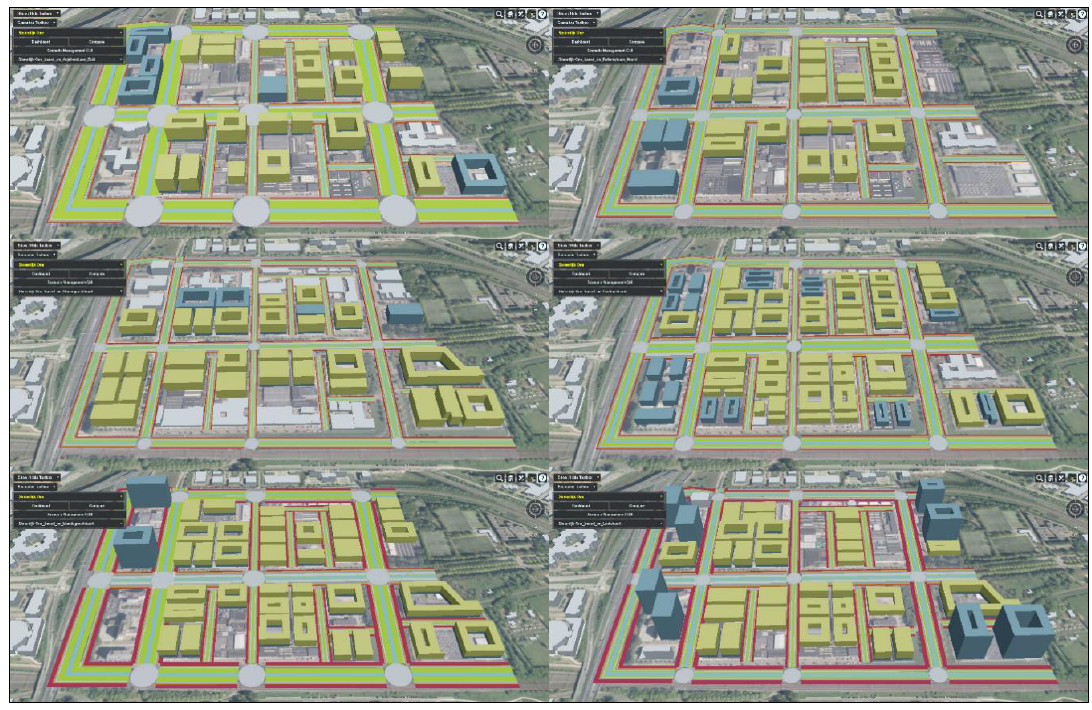
Figure 26. Examples of scenarios generated for “Sloterdijk One” using di ff erent “template”